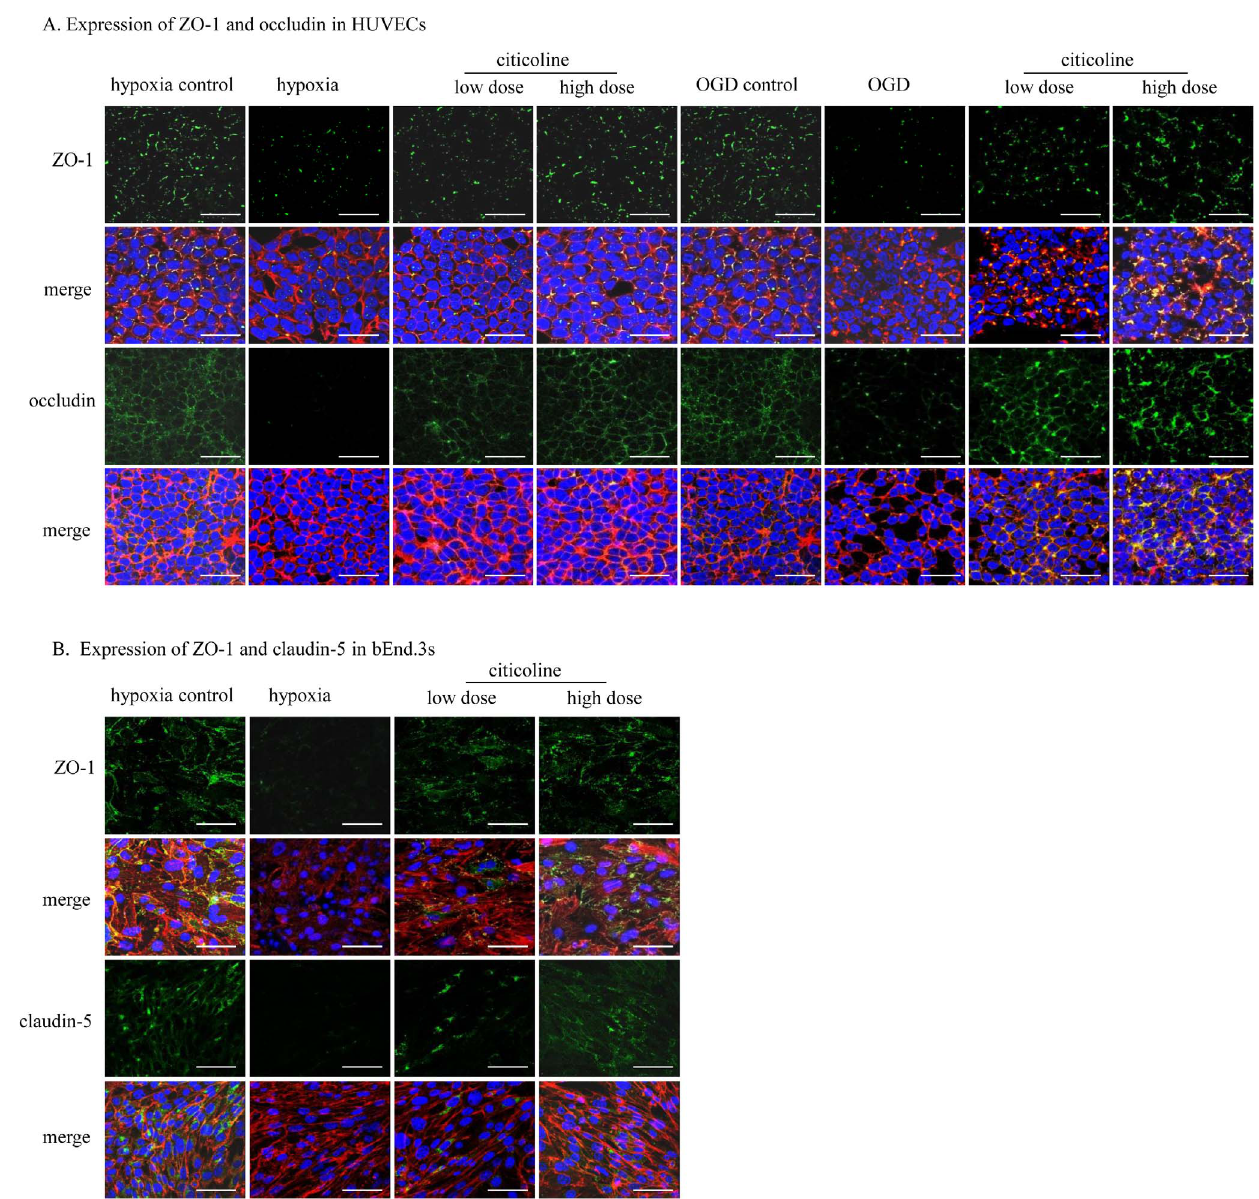
Figure 2. The effects of citicoline on Hypoxia/OGD-induced disruption of TJPs expression in endothelial cells. Representative images of TJP staining on endothelial cells. Green: ZO-1/occluding/claudin-5; Red: F-actin; Blue: nuclear. Scale bars: 50 m m. Hypoxia/OGD decreases the expression and results in a discontinuous distribution of ZO-1 and occludin on the membrane of HUVECs ( A ). Exposure to hypoxia causes a decreased expression and discontinuous distribution of ZO-1 and claudin-5 on the membrane of bEnd.3s ( B ). Treatment of citicoline restores the linear distribution of ZO-1, occludin and claudin-5.